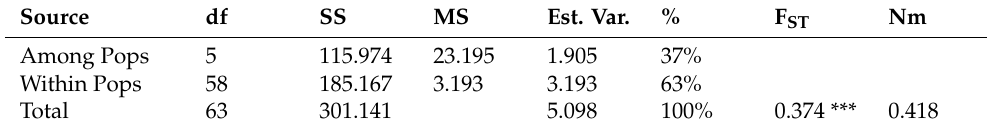
Table 5. Analysis of Molecular Variance (AMOVA) for the 6 A. araucana populations (32 specimens). Source df SS MS Est. Var. % F ST Nm Among